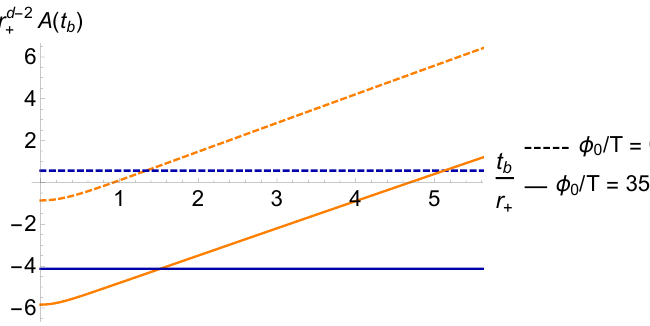
/ T = 0 and φ / T ≈ 35.0 with d = 3, ∆ = 2, Figure 9: The Page curves for φ 0 0 presented in terms of the area A and boundary time t in units of r + . The orange b curves are Hartman-Maldacena surface areas while the blue curves are island surface areas. For both, we observe a phase transition from the former to the latter at finite boundary times—the respective Page times given these